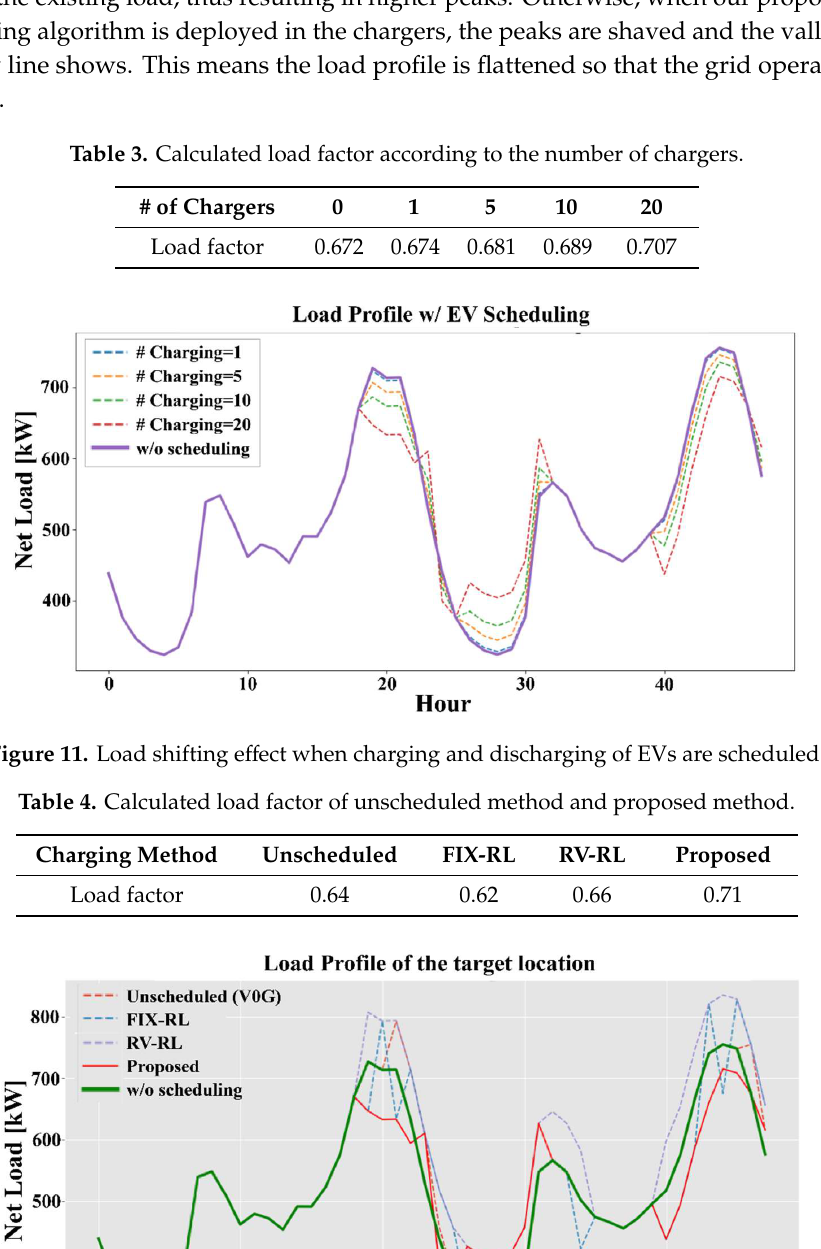
Table 3. Calculated load factor according to the number of chargers. 444